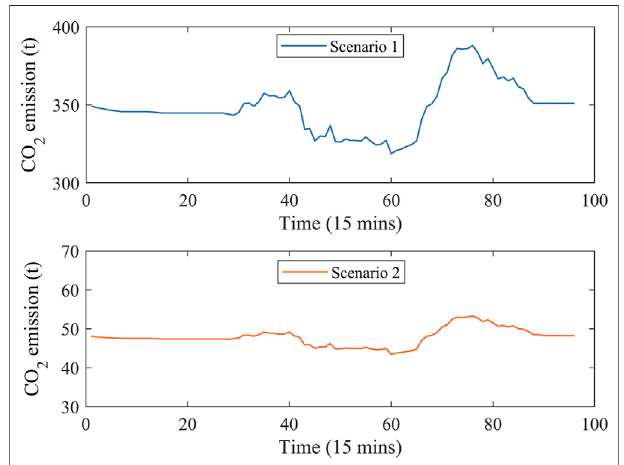
FIGURE 12 | CO 2 emissions in Scenarios 1 and 2.